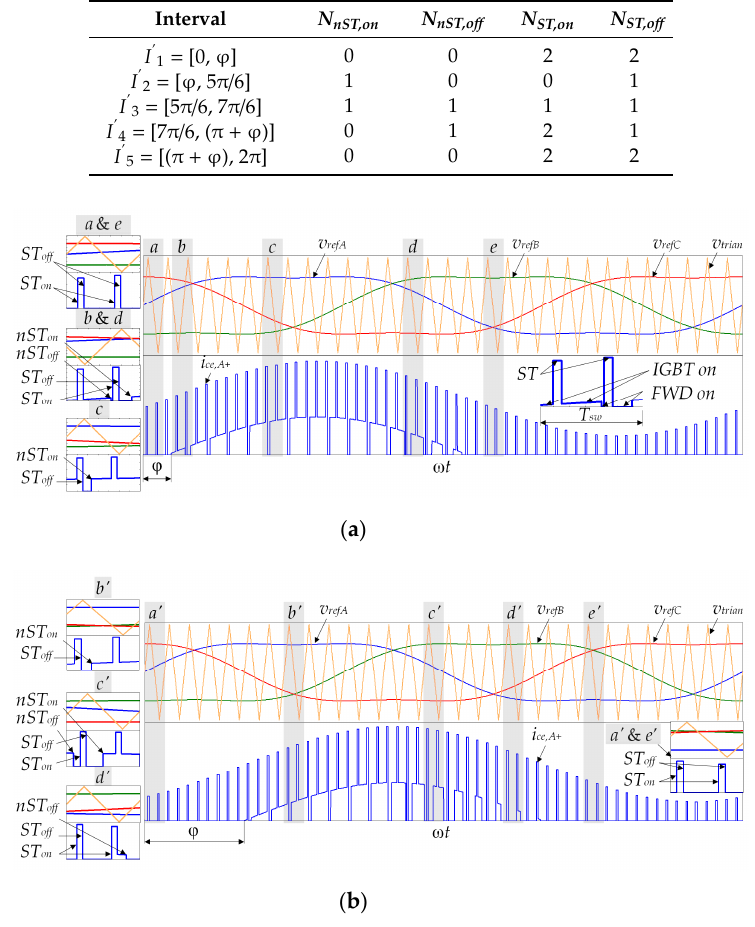
Table 2. The number of the switching transitions for the phase angle between π / 6 and π / 2. Interval N nST,on N nST,o ff